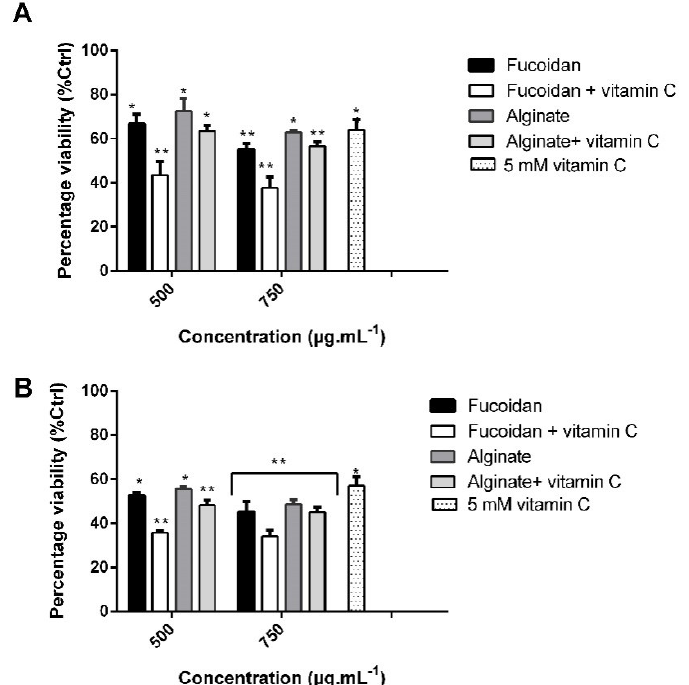
Figure 8. Influence of polysaccharides from C. sinuosa at two different concentrations and their com- bination with vitamin C on HCT-116 cell viability after ( A ) 24 h and ( B ) 48 h incubation (mean ± SD; n = 3). Significant differences are indicated as * p < 0.05 and ** p < 0.01 with respect to control.